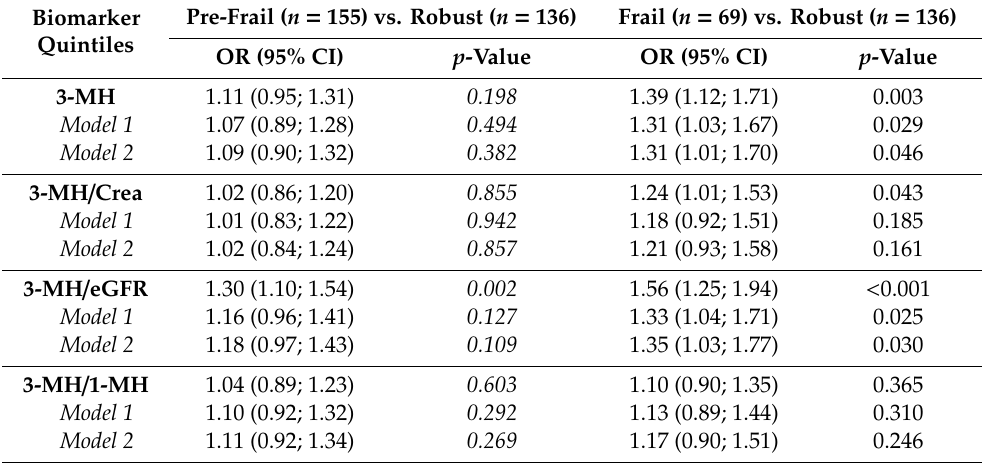
Table 4. Likelihood (simple and multivariable-adjusted odds ratios with 95 % CI) to be pre-frail and frail (robust as control group) with increasing biomarker